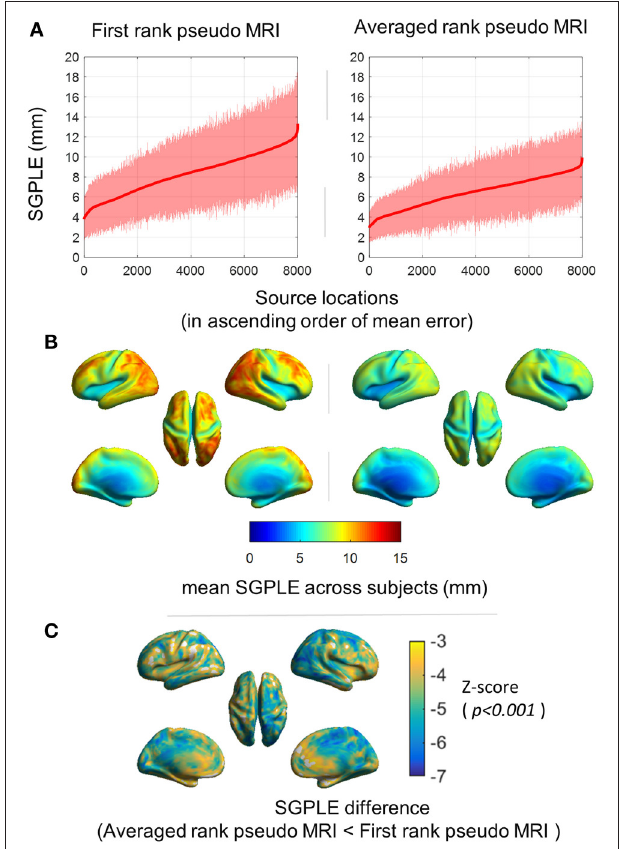
FIGURE 4 | Spatial distribution of the centroid error ( CE ). CE represents the SGPLE in a group effect. (A) Distribution of mean CE (averaged over 100 iterations) across the sourcemodel grid point locations, for different group sizes. (B) Spatial distribution of mean CE (averaged over 100 iterations) for group size of 20 subjects. (C) Spatial distribution of CE difference ( p < 0.001, Wilcoxon signed-rank test, n = 100 iterations ) between first rank pseudo MRI and averaged rank pseudo